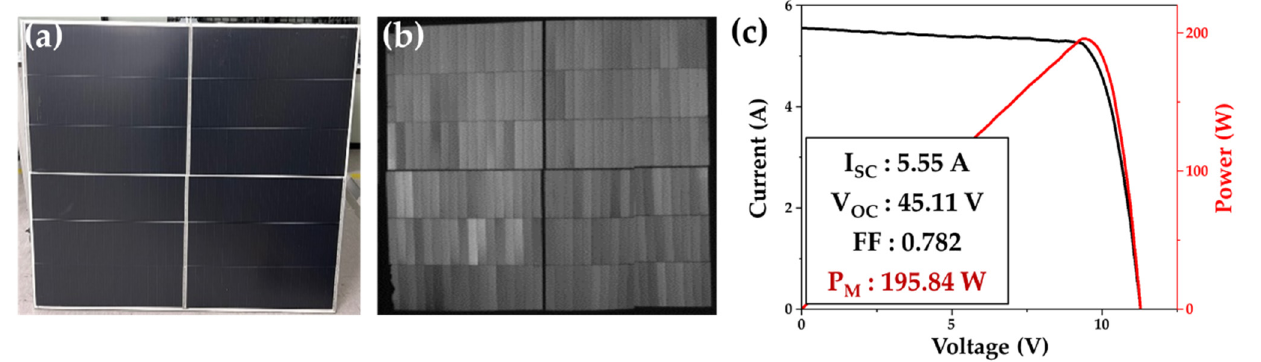
Figure 5. ( a ) Photograph, ( b ) electroluminescence images, and ( c ) I-V curve of the shingled-type lightweight PV module.